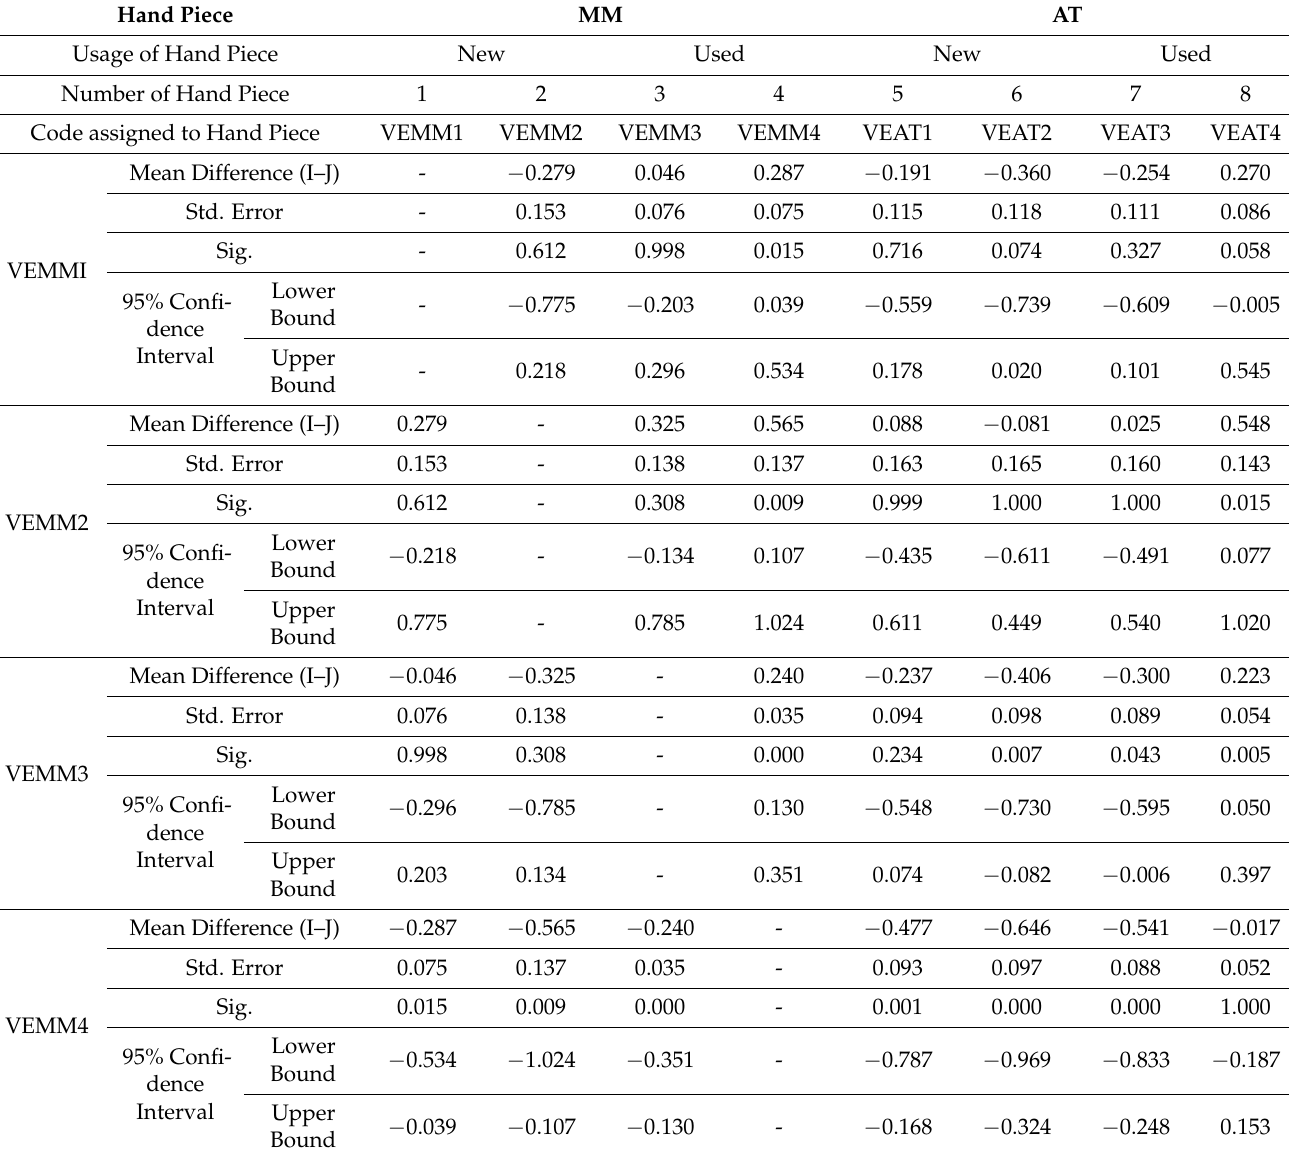
Table 11. Post hoc analysis of 1/3 octave band vibration transmission of hand